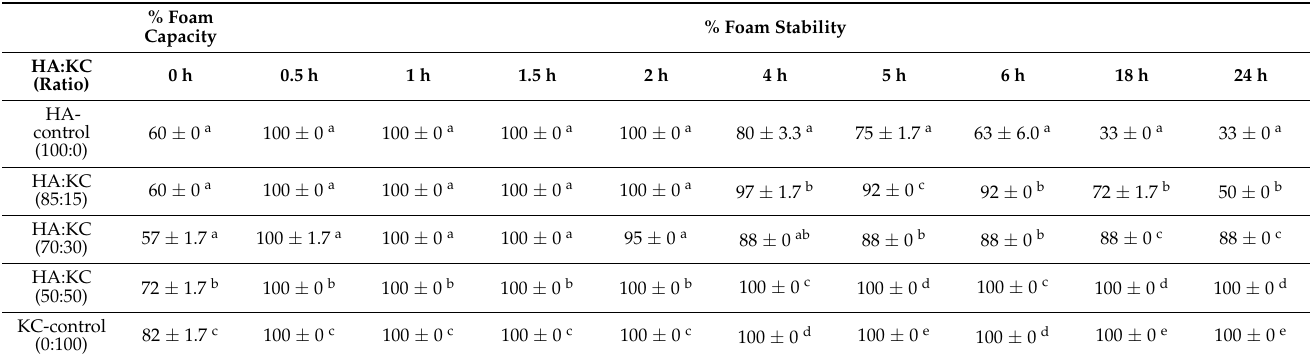
Table 6. Foaming capacity and stability of skim milk sample at 30 ◦ C treated with 0.25% HA + KC concentration and different ratios of HA + KC